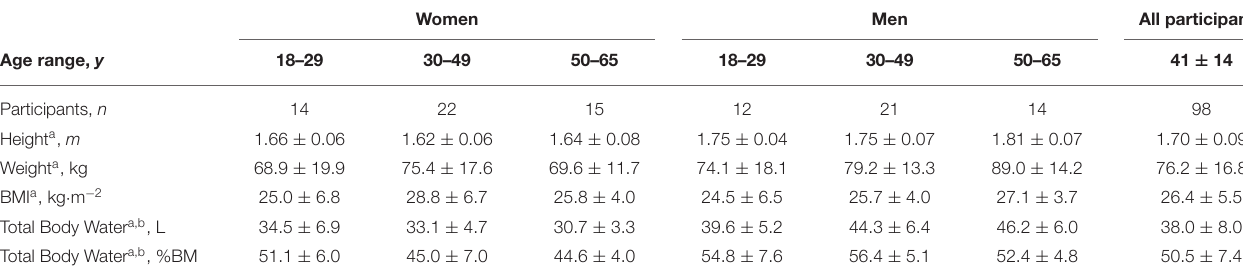
TABLE 1 | Baseline sample demographics by sex and age